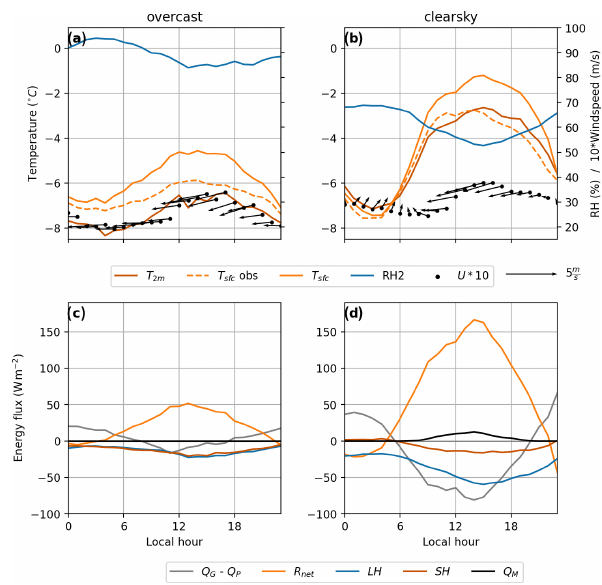
Figure C1. Average diurnal cycle in observed meteorological vari- ables and simulated energy fluxes on overcast ( N (cid:15) > 0 . 7) and clear- sky ( N (cid:15) < 0 . 3) days in December and January. R net represents S net + L net . Arrows indicate wind direction, with typically a north- easterly sea breeze and south-westerly down-glacier